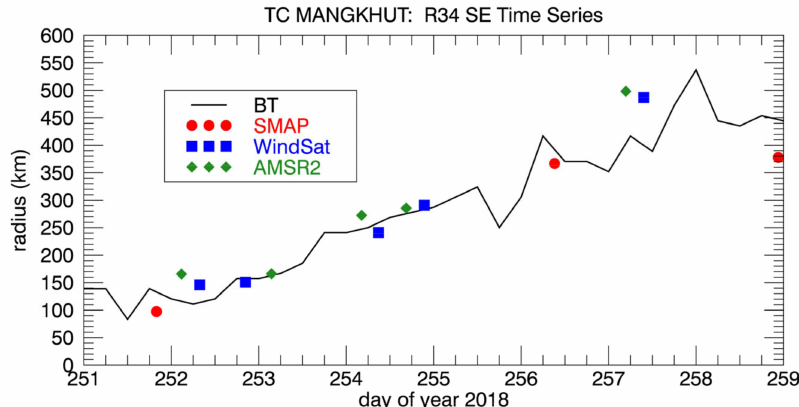
Figure 10. Time series of R34 (34 kt, 17.5 m/s, gale-force winds) in the SE sector from SMAP (red circles), AMSR2 (green diamonds) and WindSat (blue squares) passes over Super Typhoon Mangkhut in 2018. The black line indicates the R34 radii time series of the BT data.